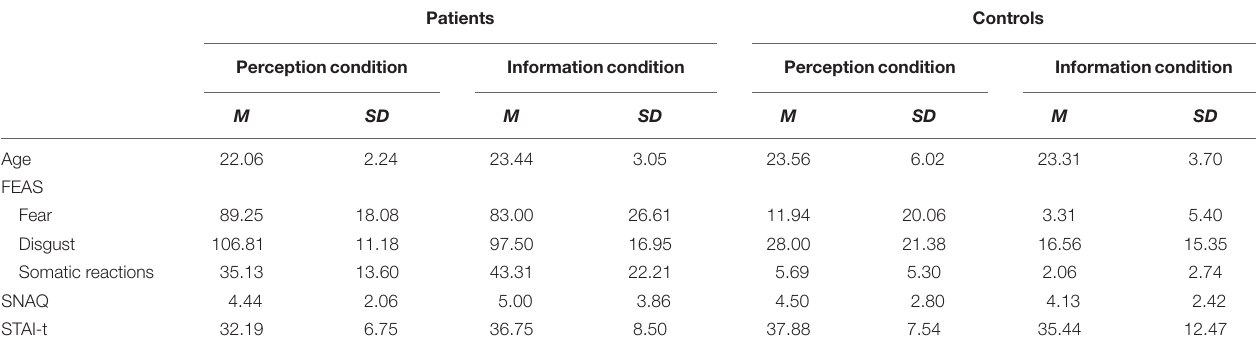
TABLE 1 | Demographic and baseline measures of the study sample. Patients Controls Informationcondition